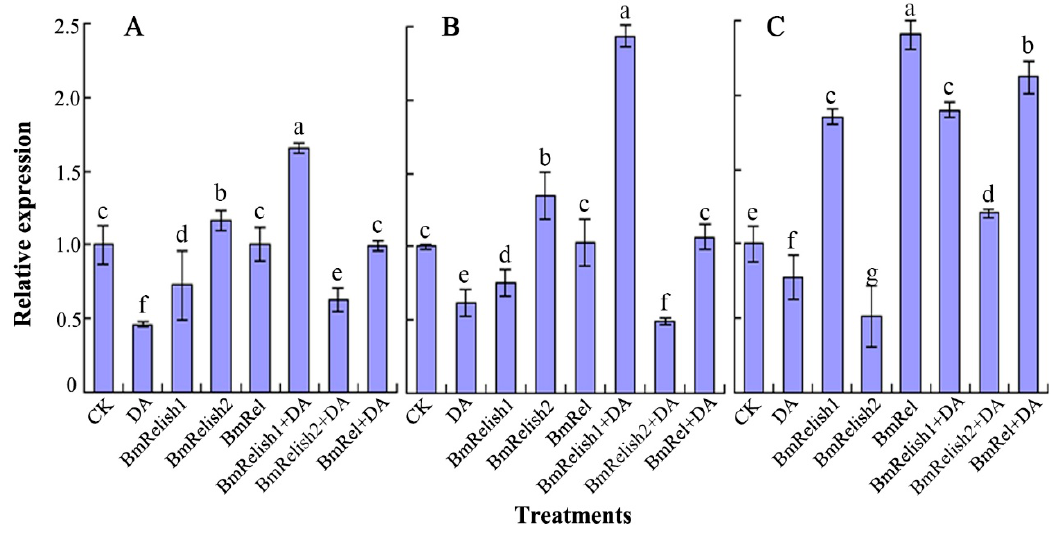
Figure 2. Effect of DA and transcription factor RNAi on the gene expression profiles of Bm_nscaf2838_045 ( A ); Bm_nscaf2674_066 ( B ); Bm_nscaf2767_133 ( C ) (CK: control; DA: destruxin A treatment; BmRelish1/2: RNAi BmRlish1/2 gene; BmRel: RNAi BmRel gene; BmRelish1/2+DA: RNAi BmRlish1/2 gene combined with DA treatment; BmRel+DA: RNAi BmRel gene combined with DA treatment). The different letters on the columns indicate the significant difference ( p < 0.05) by DMRT.